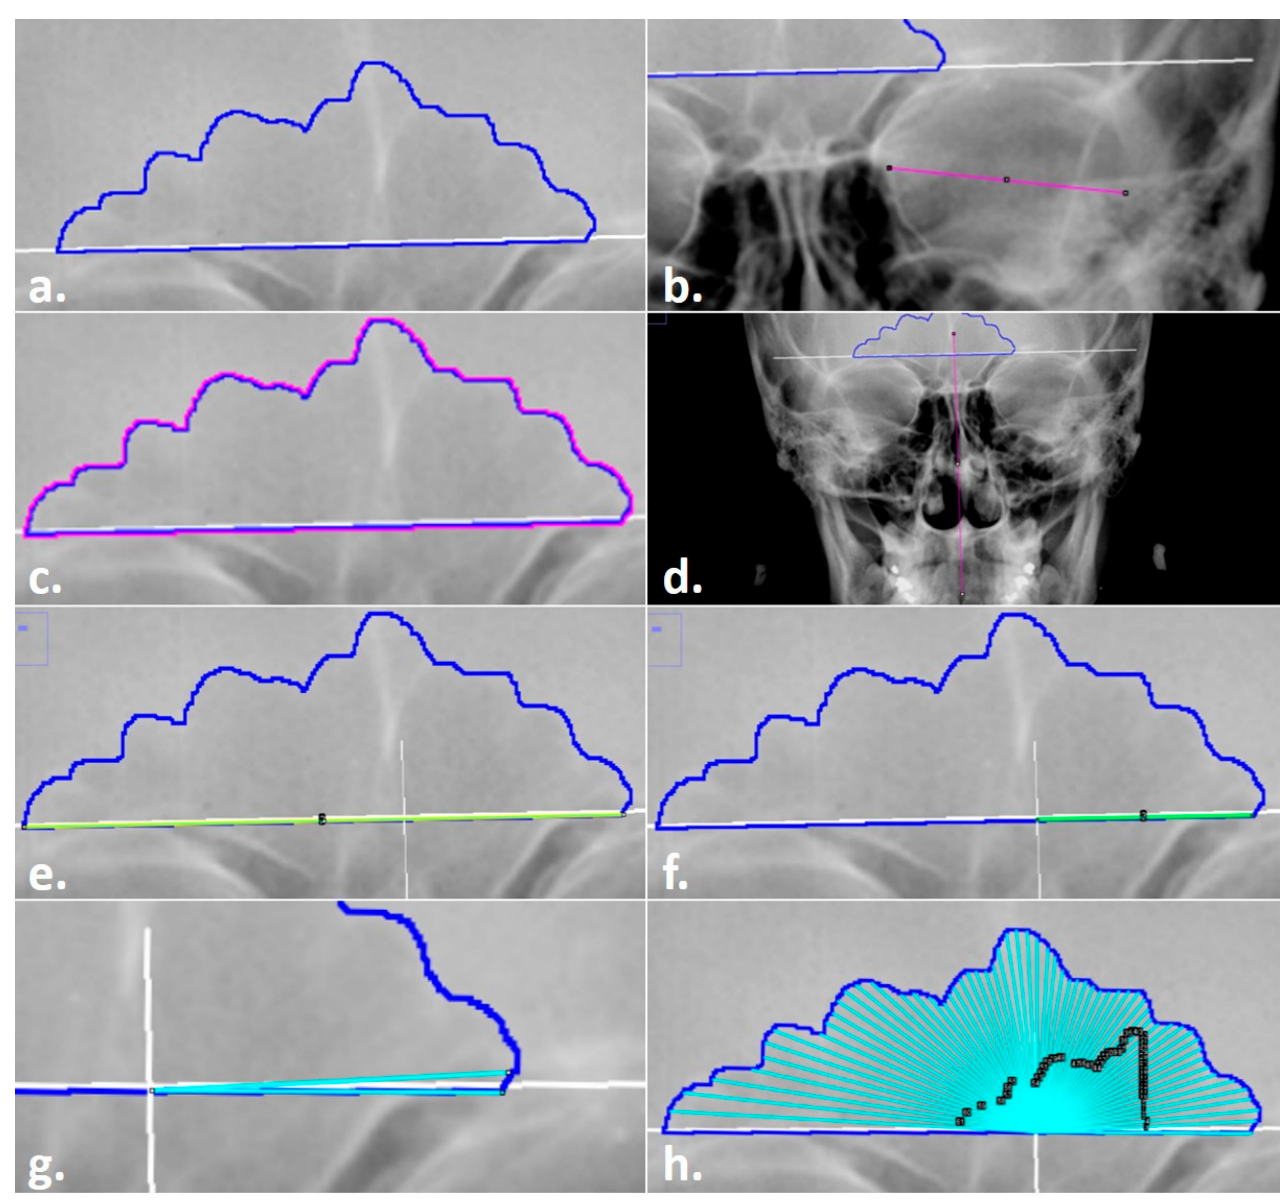
Figure 4. Steps in the Total Difference Method: ( a ) sinus outline on a radiograph; ( b ) measurement of orbital breadth for scaling; ( c ) highlighted sinus outline to be measured for the area and perimeter; ( d ) line drawn through midline landmarks to identify the origin of the sinus baseline; ( e ) line drawn for the baseline measurement; ( f ) line drawn from the origin for the right (side of the image) baseline measurement; ( g ) preliminary angle drawn at 3°; ( h ) completed angles with black ROI Manager numbered labels for editing, if required.